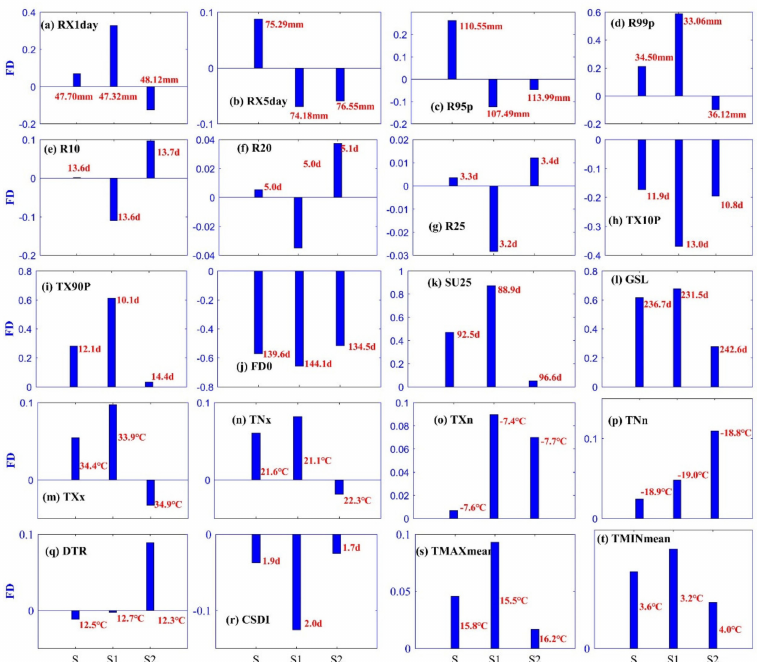
Figure 8. Variation trend of extreme climatic indices during S, S1, and S2 over the Loess Plateau region. The red values represent the average during the corresponding periods (1982–2015), and the blue columns refer to the first derivatives.